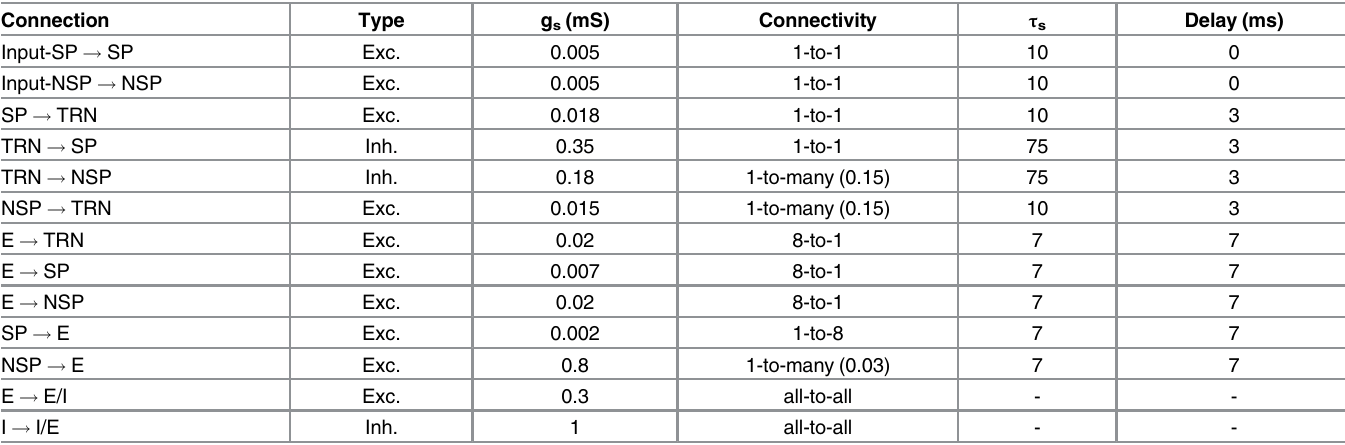
Table 1. Network connectivity values, based on